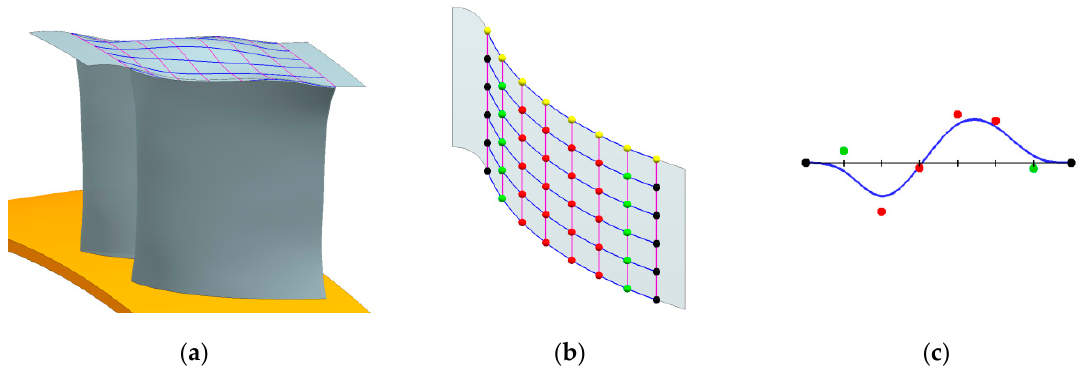
Figure 12. Parametric modeling of the stator shroud. ( a ) Illustration of the non-axisymmetric endwall of the stator shroud. ( b ) Distribution of the control points. ( c ) Amplitude of the control point and the corresponding Bezier curve.